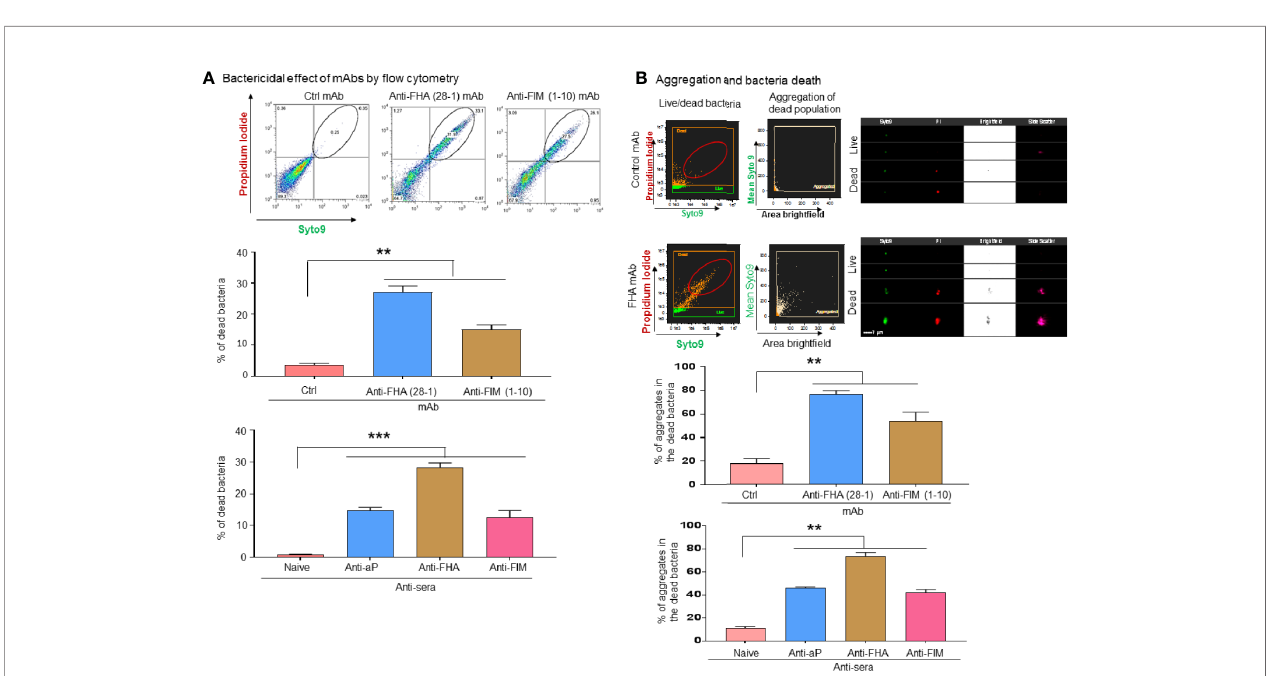
FIGURE 3 | B. pertussis sequestration by aggregation inducing antibodies mediated direct bactericidal effects. B. pertussis was incubated for 48 h with anti- pertussis antibodies without A549 cells to test the direct bactericidal effect of anti-FIM and anti-FHA antibodies. Flow cytometry-based analysis of bacteria death shows that anti-pertussis antibodies against FIM and FHA exhibit direct bactericidal effect (A) . Furthermore, analysis by imaging fl ow cytometry showed that majority of dead bacteria are within the aggregates (B) . Unpaired Student ’ s t -test. Mean±SEM. ** p <0.01 and *** p <0.001, n ≥ 3